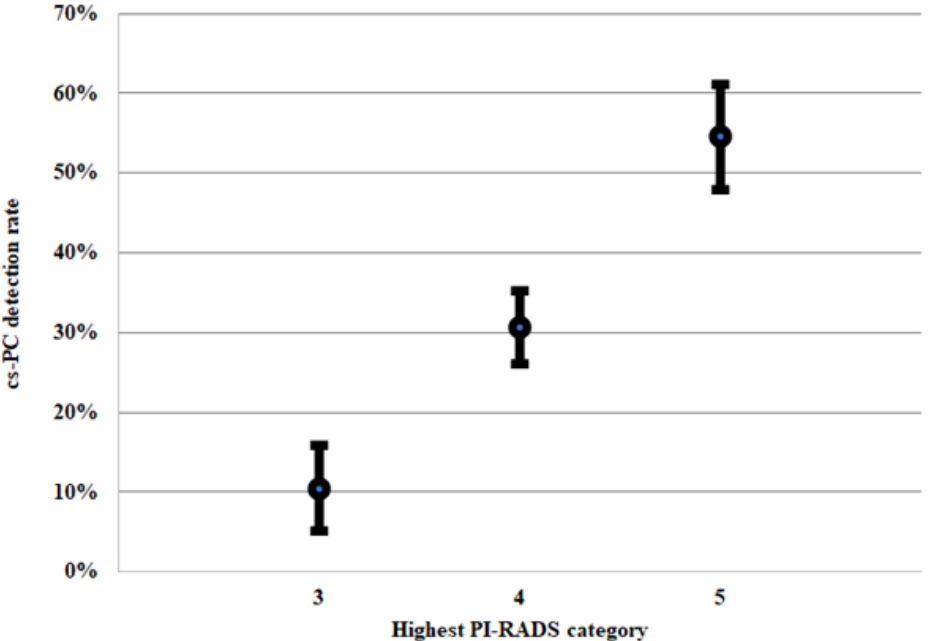
Figure 1. Detection rates of clinically significant prostate cancer (cs-PC) among patients with the highest Prostate Imaging Reporting and Data System (PIRADS) categories 3, 4, and 5. The whiskers represent 95% confidence intervals. Table 2. Association between clinically significant prostate cancer (csPC) diagnosis and other factors, DRE